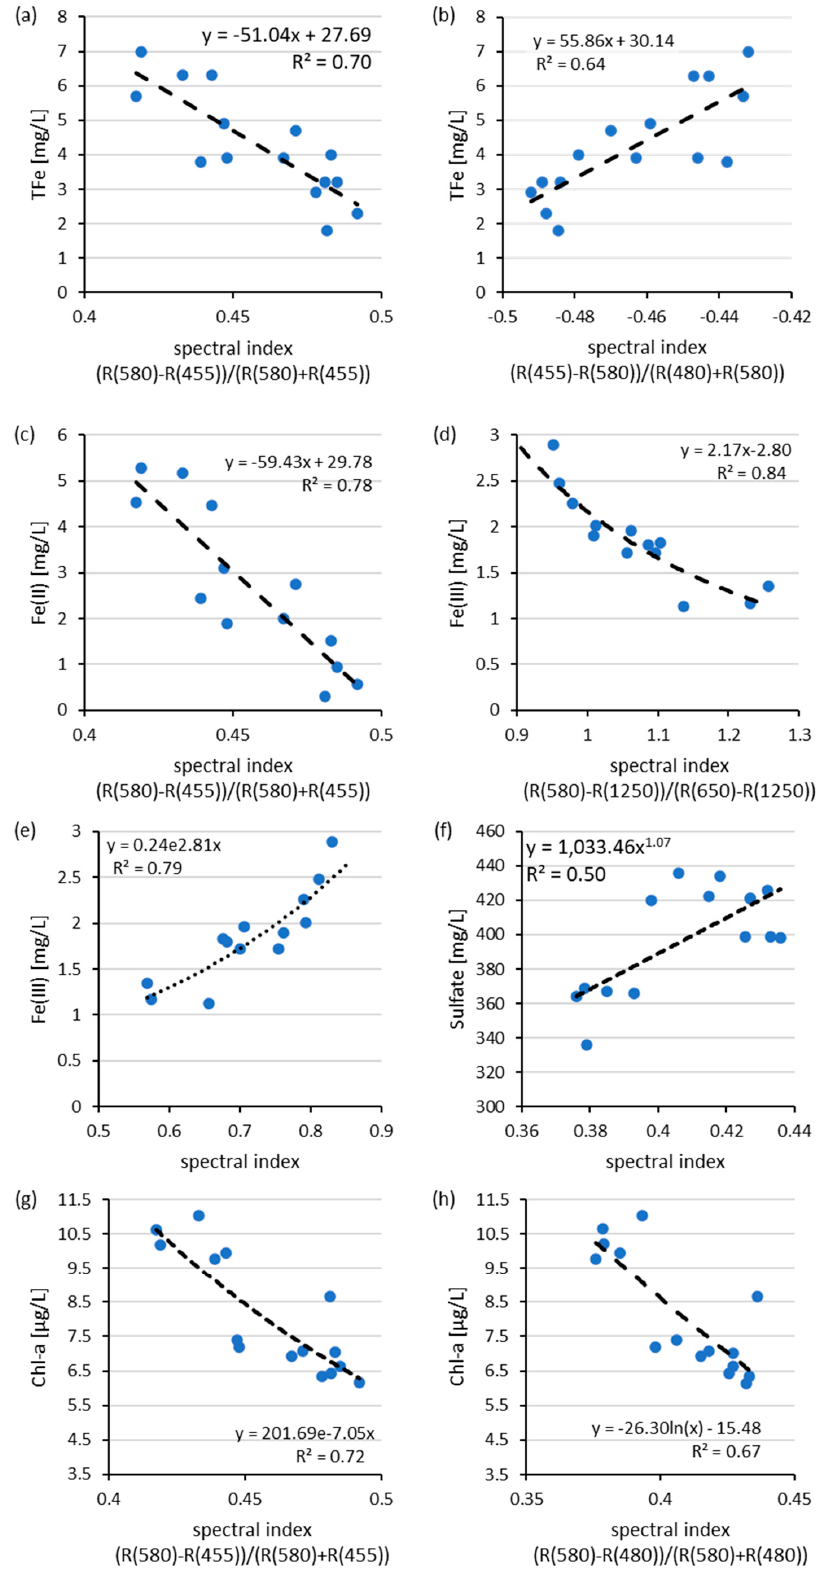
Figure 7. Representation of the regression models (in Table 3) showing the regression equivalence and the coefficient of determination. ( a – h ) The most suitable regression models to link particular spectral indices to water